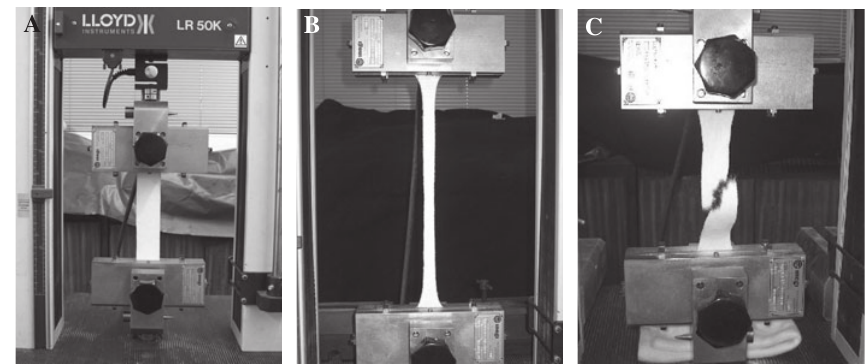
Figure 3 Tensile tests according to EN 29073-3: (A) begin of the test; (B) during the test; (C) end of the